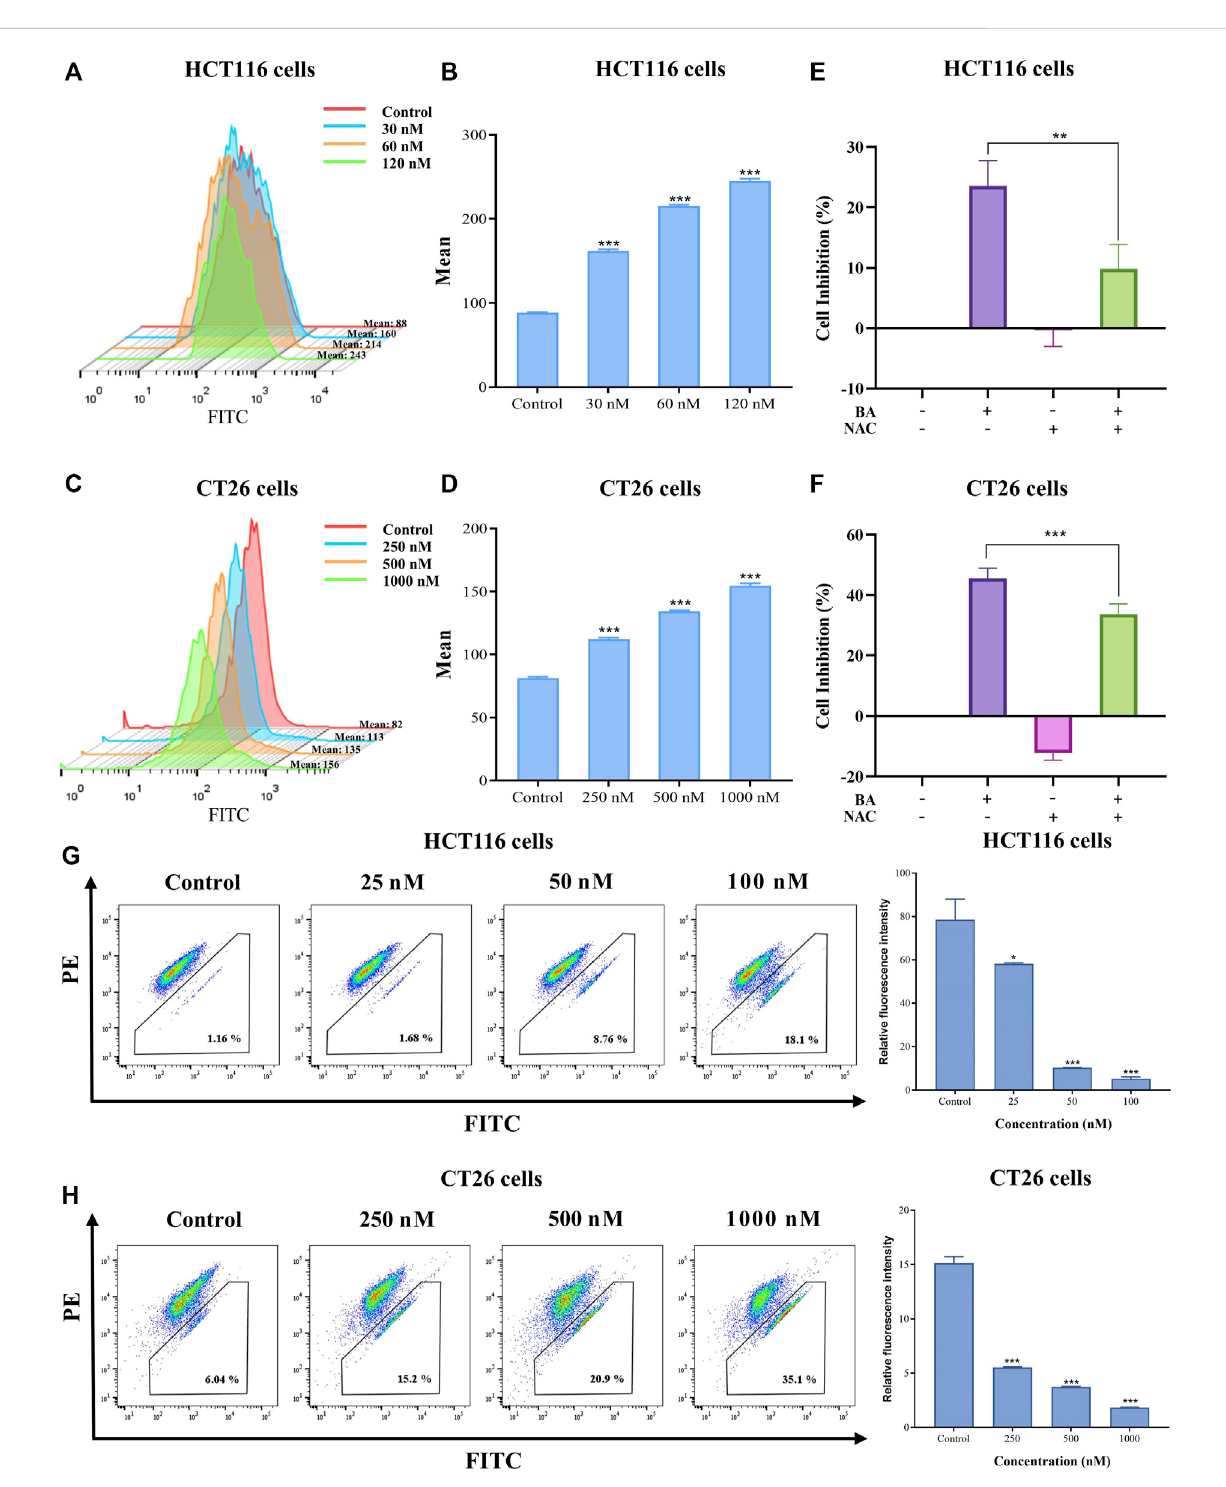
FIGURE 7 BA induced ROS production and collapsed MMP. (A – D) BA induced ROS production in HCT116 (A) and CT26 (C) cells Statistical analysis of the median fl uorescenceintensity ofROSinHCT116 (B) andCT26 (D) cellstreatedwithBA. (E,F) Thecell inhibitionrateofHCT116 (E) andCT26 (F) cellswere treated with BA and/or NAC (2 mM) for 48 h (G,H) The changes in MMP in BA-treatedHCT116 (G) and CT26 (H) cells. ** p < 0.01, *** p < 0.001, compared to the control